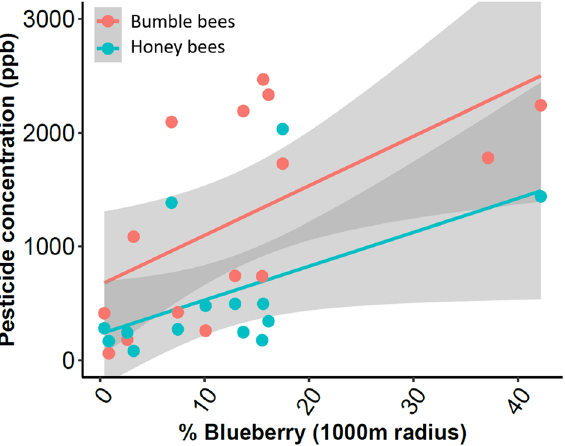
Figure 4. Relationships between percent of the landscape in blueberry production within 1000 m of bee colonies and the concentration of pesticides detected in pollen collected by bumble bees (red) and honey bees (blue). Lines indicate smoothed linear regression lines with 95% confidence intervals. Graph created in R 30 v3.6.2 with the package ggplot2 43